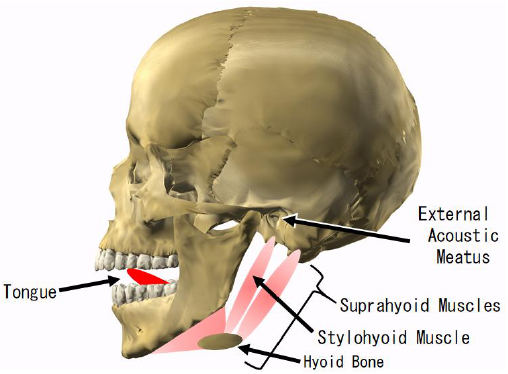
Figure 1. Anatomy of the tongue and external acoustic meatus. When the user pushes the tongue against the roof of the mouth, the suprahyoid muscles, including the stylohyoid muscle, expand and contract. The shape of the adjacent external acoustic meatus changes as a result of this expansion and contraction.